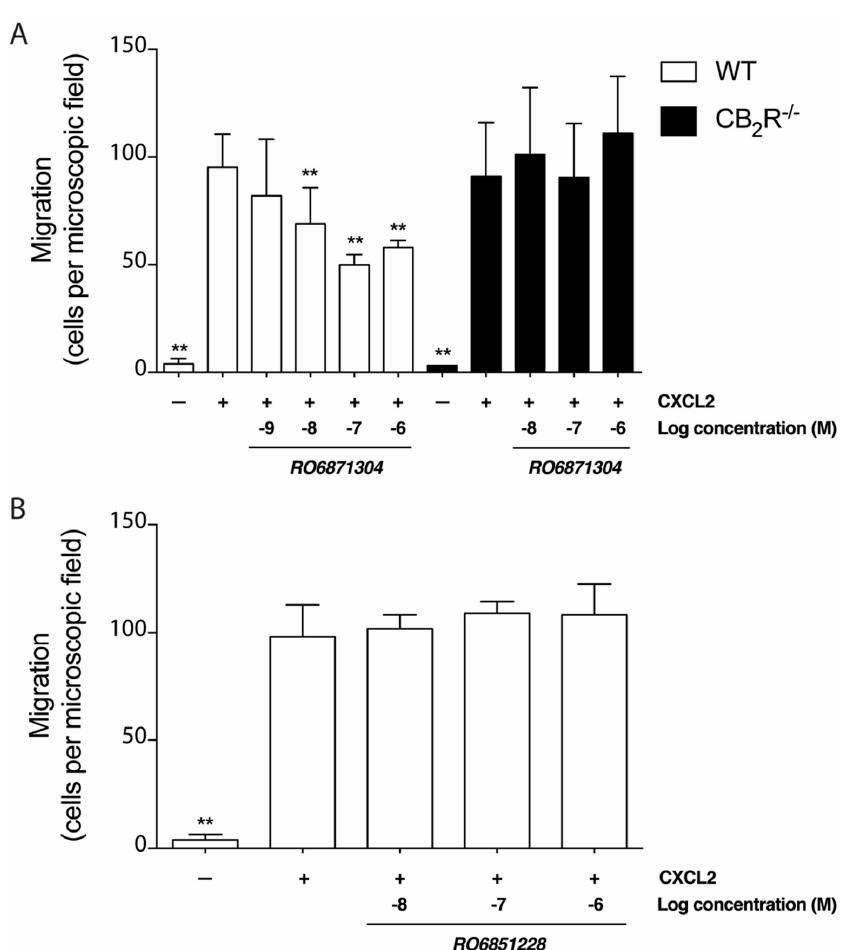
Figure 4. CB 2 R activation reduces neutrophil migration towards chemoattractant. ( A ) Bar graph represents the mean number of neutrophils from WT or CB 2 R - / - mice pre-treated with various concentrations of the CB 2 R agonist, RO6871304, that migrated to the lower chamber of a Boyden chamber setup when using CXCL2 (10 − 8 M) as a chemoattractant. Neutrophils were counted from 12 random microscopic fields of view per well. ( B ) Bar graph represents the mean number of neutrophils from WT mice pre-treated with various concentrations of the CB 2 R inverse agonist, RO6851228, or vehicle (0.01% DMSO) that migrated in the Boyden chamber setup. Data are presented as the mean neutrophil migration per microscopic field of view ± SD from at least three independent experiments conducted in triplicate each. One-way ANOVA with Dunnett; ** p < 0.01 compared to WT neutrophils + CXCL2 +